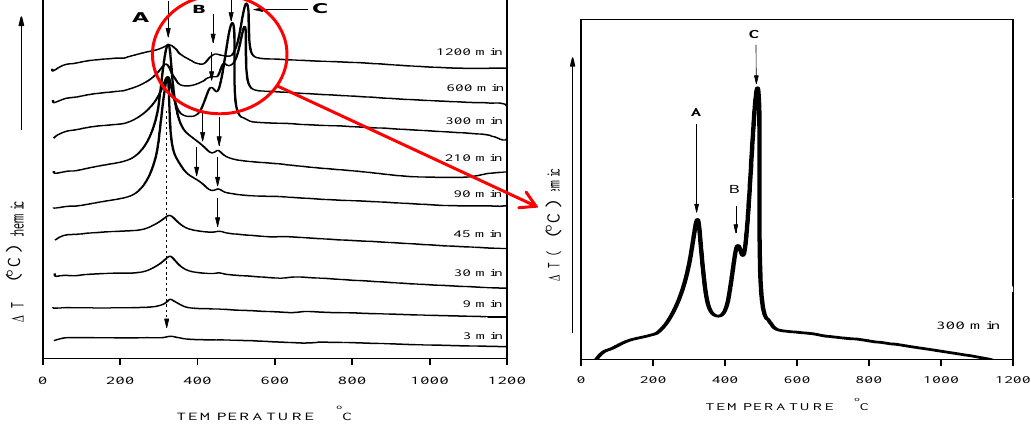
Figure 1. Differential scanning calorimetry of Lithium Niobate (LiNbO 3 ) for 3 to 1200 min of milling. Inset: exothermic peaks for 300 min of milling